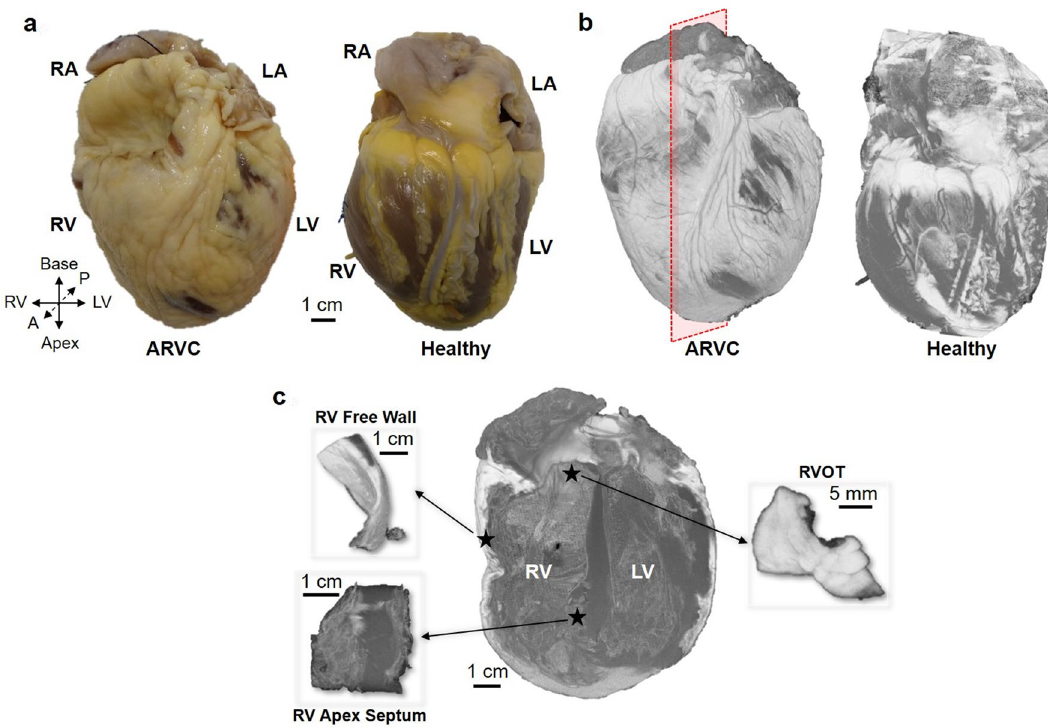
Figure 1. Presentation of the ARVC and healthy hearts. Photograph ( a ) of the ARVC heart (dimensions 13 × 10 × 9.6 cm 3 ) and of the healthy heart (dimensions 13.9 × 8.1 × 7.9 cm 3 ). ( b ) 3D reconstructions of both hearts from the fat fraction maps computed from high resolution MR images. Red plane in image on the left corresponds to the long axis plane. ( c ) ARVC heart is cropped in long axis view (red plane in b ) to show the three sub-regions of “ARVC triangle”: the right ventricle (RV) free wall, the RV apex septum and the right ventricle outflow tract